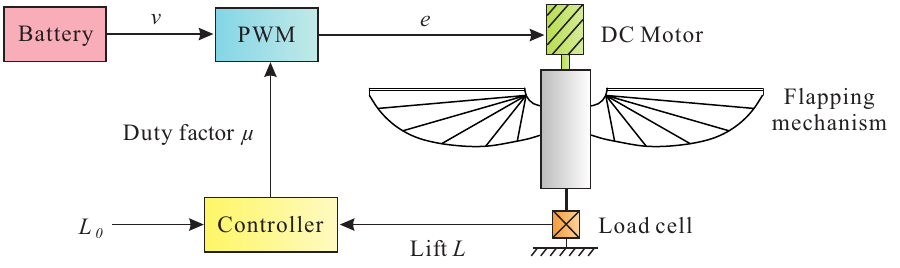
Figure 14. Experimental set-up for the endurance test.